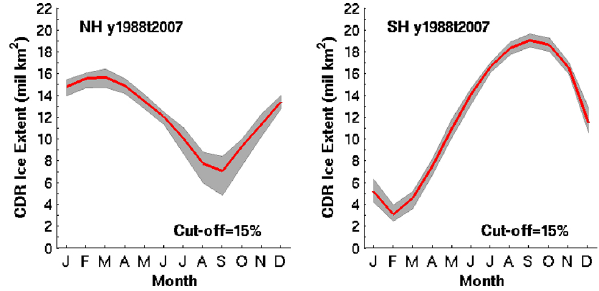
Figure 5. 20yr (1988–2007) mean monthly CDR sea ice extent (solid line) for the Northern (left) and Southern (right) Hemi- spheres. The shaded areas are bounded by the minimum and maxi- mum extent values for each month.